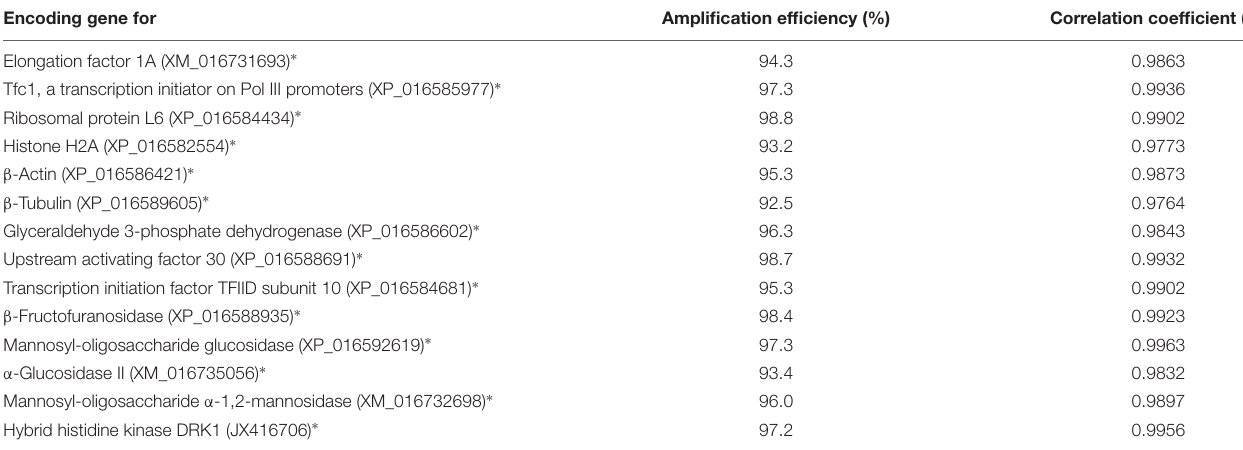
TABLE 2 | Amplification reaction efficiency for the different amplicons analyzed in this study. Encoding gene for